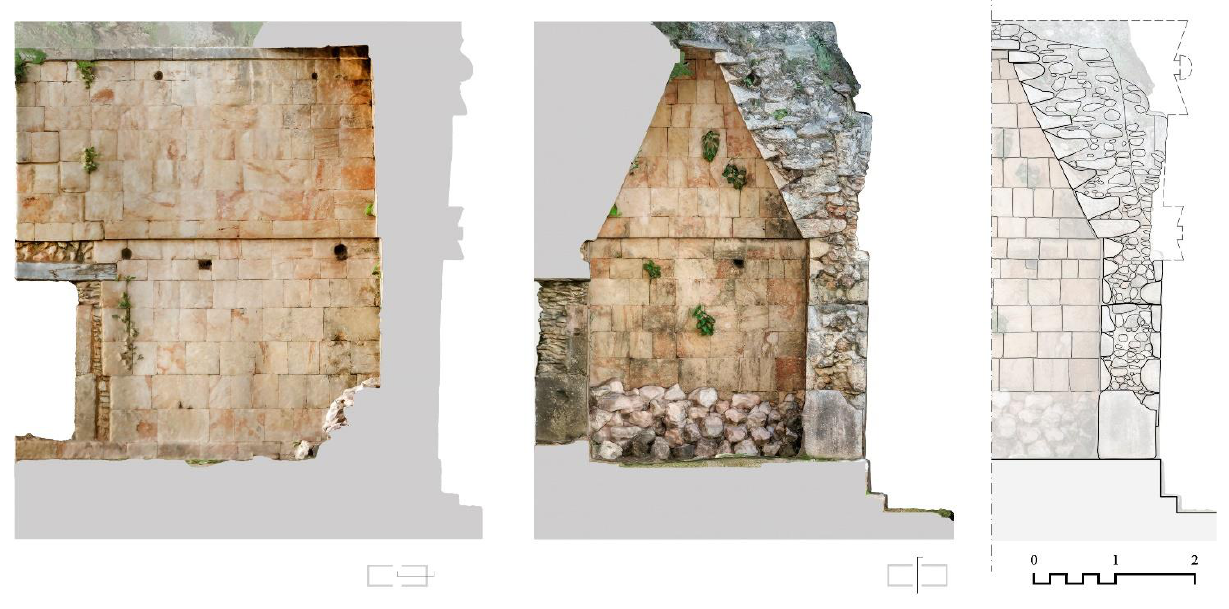
Figure 8. Scaled orthophotos and constructive section of room 1 of the House of the Turtles obtained from the photogrammetric